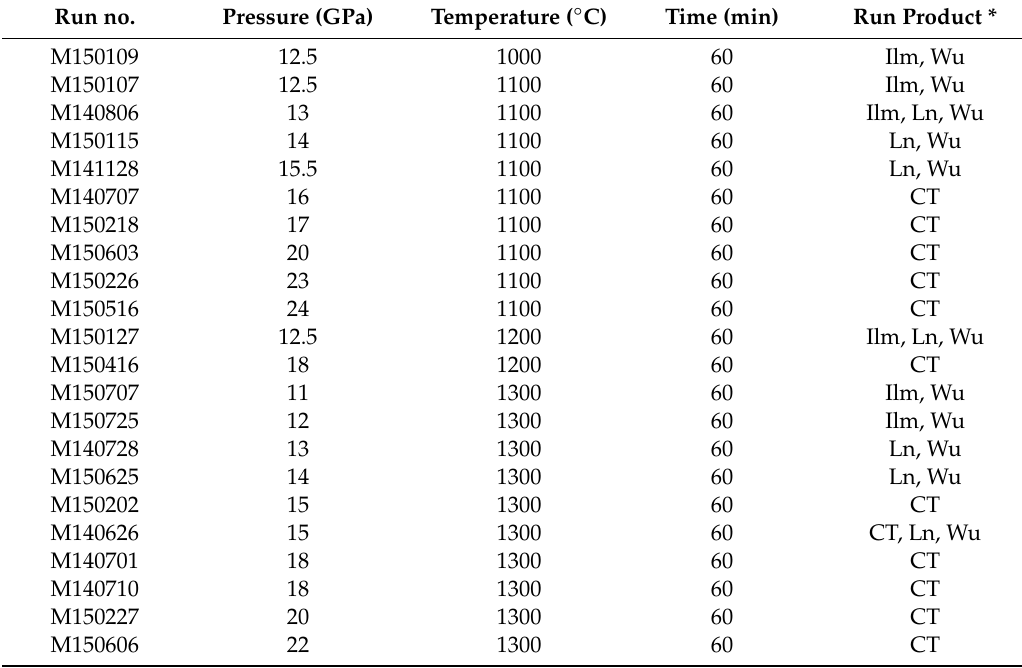
Table 3. Results of high-pressure and high-temperature experiments in Fe 2 TiO 4 . Run no. Pressure